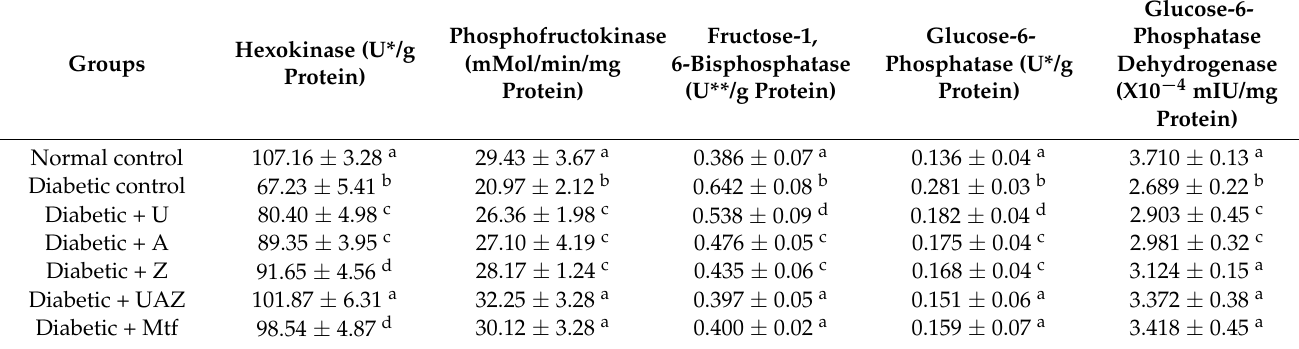
Table 3. Effect of U, A, and Z and UAZ on activities of hexokinase, phosphofructokinase, fructose-1, 6-bisphosphatase, glucose-6-phosphatase, and glucose-6-phosphatase dehydrogenase.